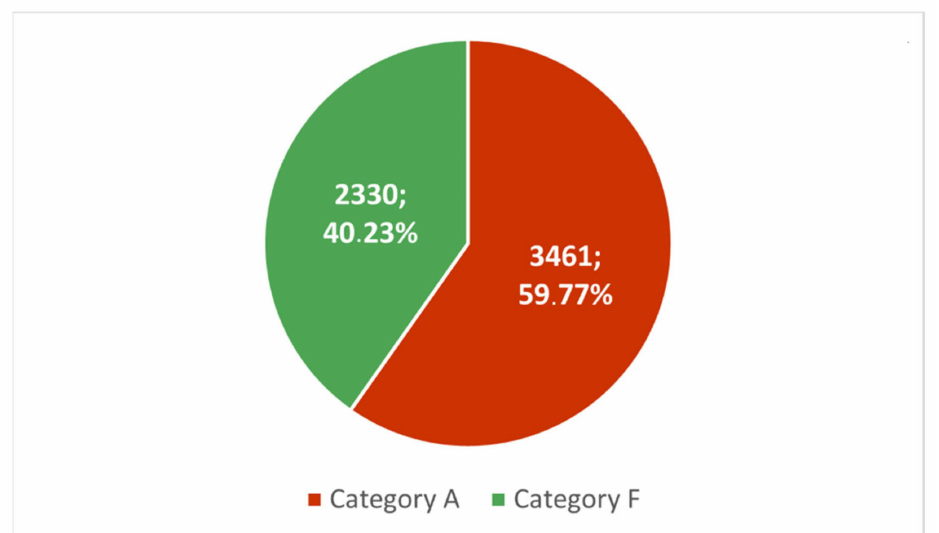
Figure 6. The summary of the number and percentage of retweets received by top-10 tweets is divided into Category A tweets (against vaccination mandate) and Category F tweets (in favour of vaccination mandate). Approx. 60% of the analysed content belongs to Category A (against mandatory vaccination).